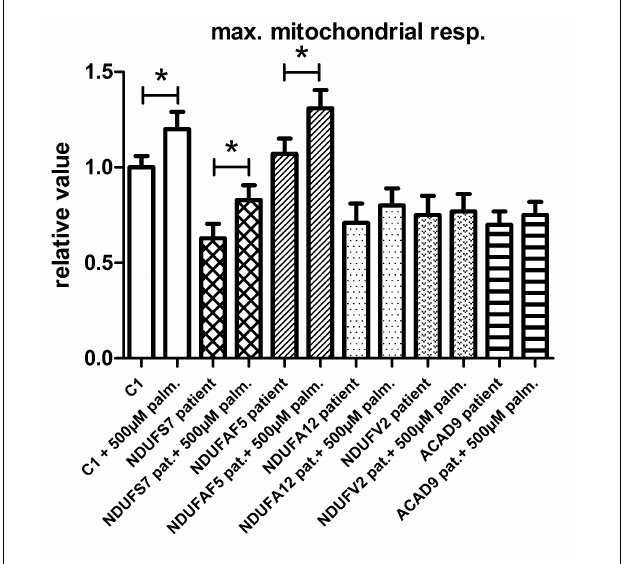
FIGURE 3 | The effect of palmitic acid on the maximal respiratory capacity in fibroblasts. Control (C1) and patient fibroblasts with defects in the complex I subunit and assembly factor genes NDUFS7 (p.V122M), NDUFAF5 (p.L159F), NDUFA12 (c.83dup, frameshift), NDUFV2 (p.A183T), and ACAD9 (p.R532W) were treated with palmitic acid prior to seahorse analysis. NDUFS7 and NDUFAF5 cells were responsive to palmitic acid as a significant increase of, respectively, 32 and 22% in maximal respiratory capacity was measured. No significant changes in maximal respiration were measured in NDUFA12, NDUFV2, and ACAD9 defective fibroblasts. ∗ Statistically significant.